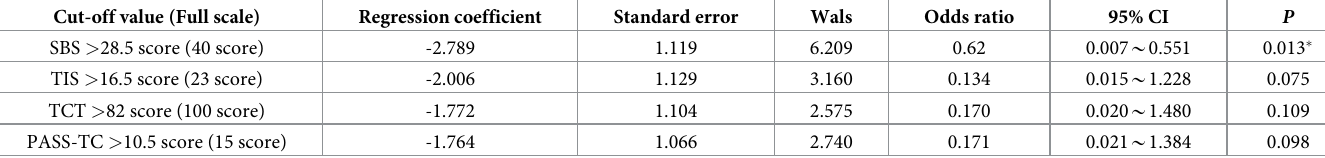
Table 5. The odds ratio for estimating the mobility level of each variable. Cut-off value (Full